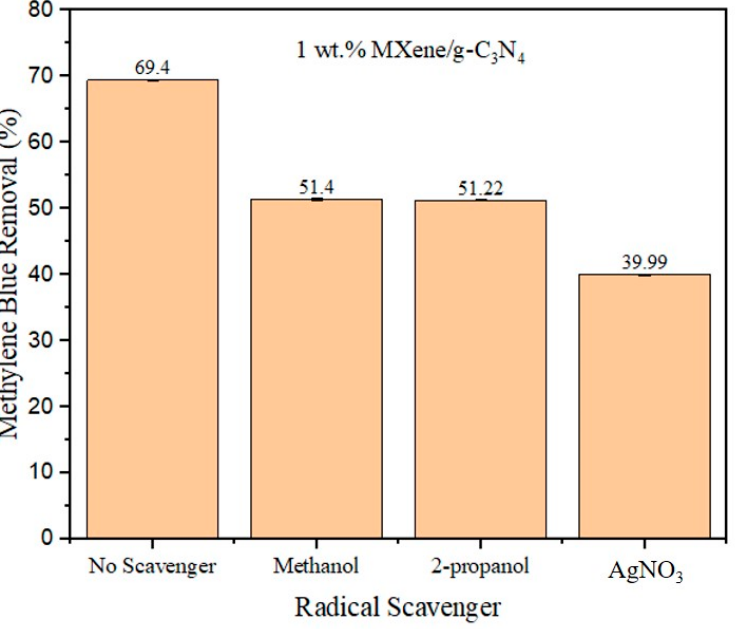
Figure 10. Active sites radical trapping studies on the as-synthesized 1 wt.% MXene/g-C 3 N 4 heterostructure photocatalysts.